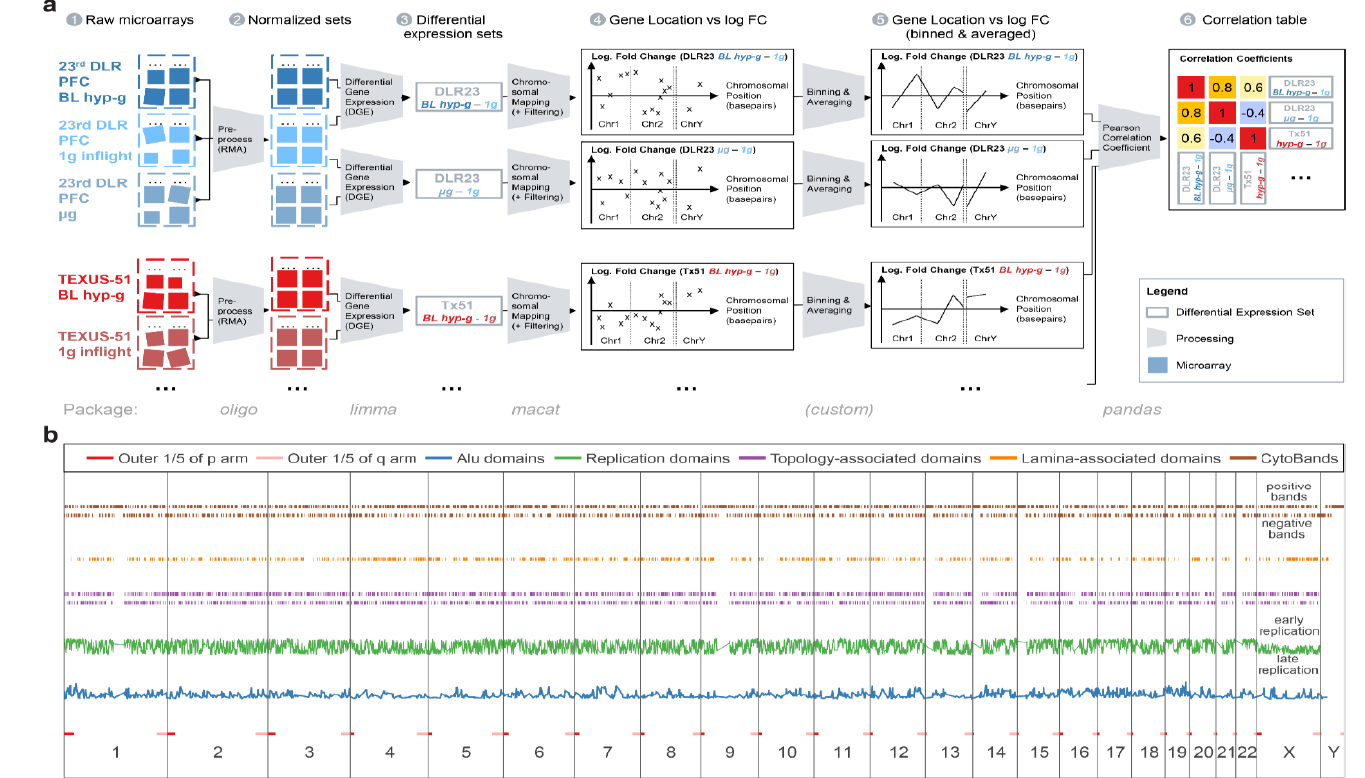
Figure 10. Components of the analysis pipelines. ( a ) Schematic overview of the sample analysis pipeline. (1) Raw array data were available as CEL files for all compared experiments (except for control experiment 2 that was already in a normalized state). (2) Raw array data were RMA-normalized (Robust Multiarray Averaging) and converted into experiment-wise transcript cluster data. (3) Differential gene expression comparisons were calculated with Bioconductor limma by fitting a linear Bayesian model to the data. (4) Data were annotated with their distinct localization on the human genome and mapped to all chromosomes. Only uniquely mapping genes were kept; additionally, only the top 2000 differentially expressed genes were included. (5) Genes were binned into bins of 10,000,000 bp and averaged within bins. The bin logarithmic fold change averages were plotted at the middle of the bins, chromosome by chromosome. (6) The Spearman correlation coefficients of all bin averages were calculated between different DGEs comparisons, yielding a correlation coefficients table with all DGEs comparisons. The value between two identical sets is always 1 and is represented on the diagonal. ( b ) Distribution of all DNA motifs that were used in linear models for the hypotheses testing. The horizontal axis shows the chromosomes, from chr1 to chrY, aligned from the beginning of the p arm to the end of the q arm. The outer 1/5 of the p/q arm are displayed in red, and the number of Alu domains within 100,000 bp on the same chromosome is displayed per location in blue, on a relative scale.